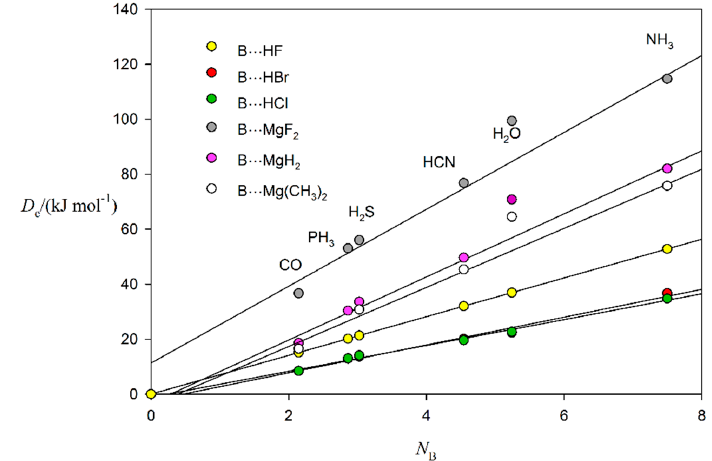
Figure 8. D e versus the nucleophilicity, N B , for the B ··· MgR 2 series and B ··· HX complexes (B = CO, HCN, H 2 O, NH 3 , H 2 S and PH 3 ; R = F, H or CH 3 ; X = F, Cl or Br). The N B values are defined by the B ··· HF straight line through the origin (see text for details). The points for H 2 O ··· MgR 2 were excluded from the regression fits for reasons discussed in the text. The lines and points for B ··· HCl and B ··· HBr are almost coincident. ( R 2 = 0.994, 0.994, 0.990, 1.000, 0.993 and 0.988 for the Mg(CH 3 ) 2 , MgH 2 , MgF 2 , HF, HCl and HBr lines, respectively).